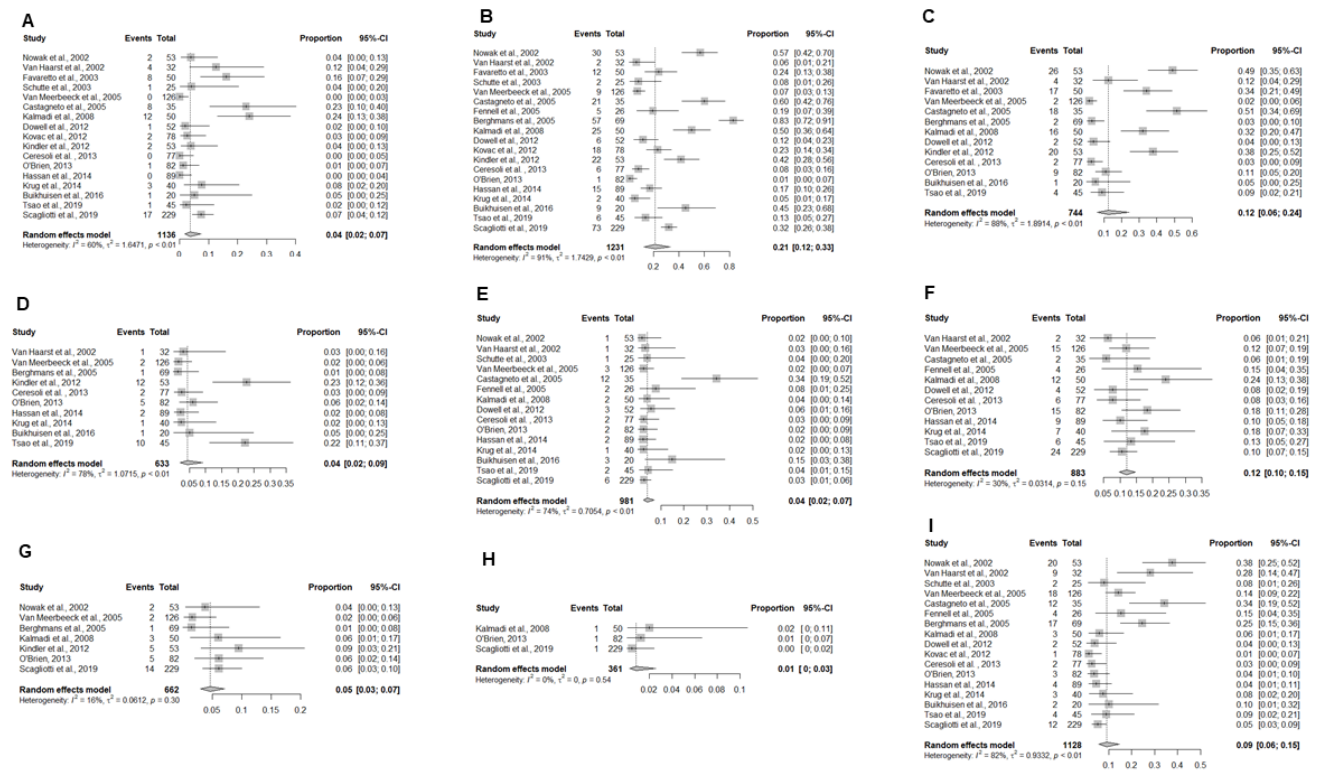
Figure 3. Forest plots demonstrating the toxicity outcomes for various experimental regimens: ( A ) Anemia; ( B ) Neutropenia; ( C ) Thrombocytopenia; ( D ) Cardiac Toxicity; ( E ) Gastro-intestinal toxicity; ( F ) Fatigue; ( G ) Infections; ( H ) Skin toxicity; and ( I ) Nausea and vomiting. Squares indicate the proportions from individual studies and horizontal lines indicate the 95% confidence interval. The size of the data marker corresponds to the relative weight assigned in the pooled analysis using the random effects model. The diamond indicates the pooled proportion with 95% CI.